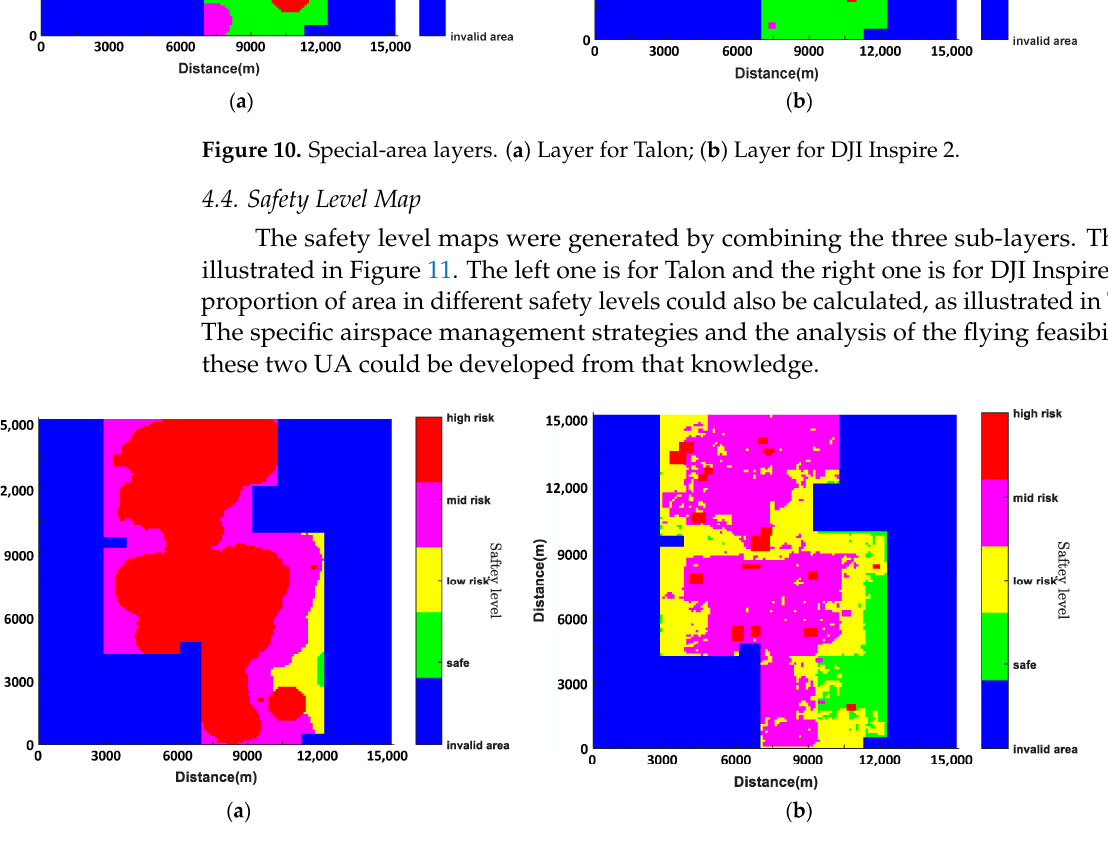
Figure 11. Safety level maps. ( a ) Map for Talon; ( b ) Map for DJI Inspire 2. Table 7. The proportion of areas in different safety